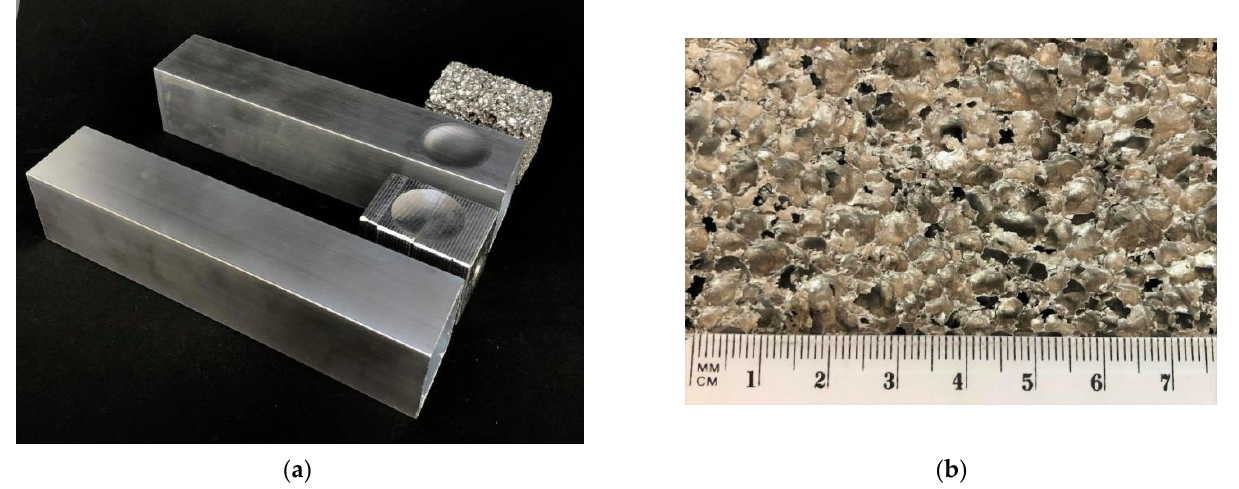
Figure 8. ( a ) The shape of the experimental specimen with matrix and foam filling presentation; ( b ) close-up of porous structure.